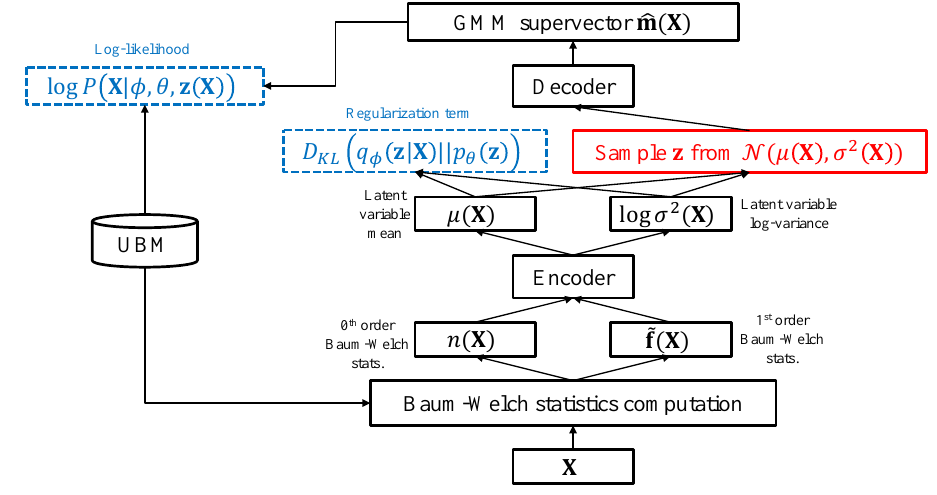
Figure 1. Proposed variational autoencoder (VAE) for non-linear feature extraction. Blue shows the loss terms. Red shows the sampling operations. GMM: Gaussian mixture model; UBM: universal background